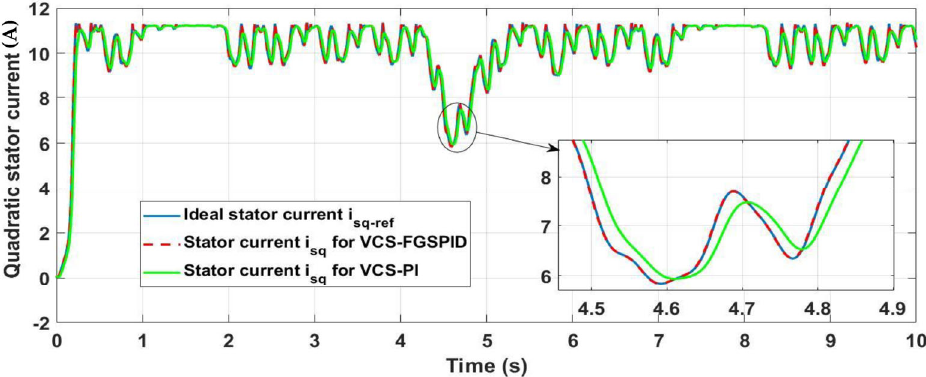
Figure 38. Hardware co-simulation for quadratic stator current.